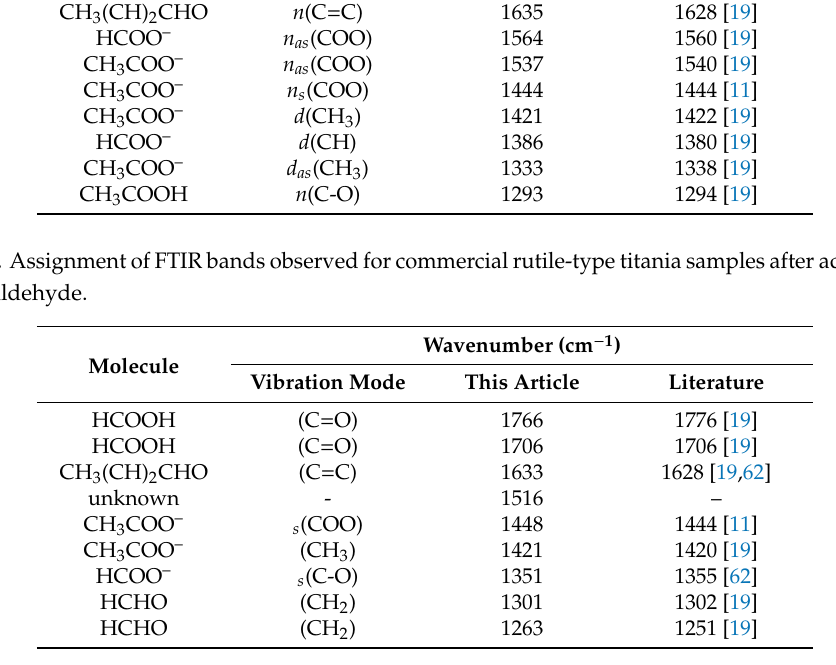
Table 7. Assignment of FTIR bands observed for commercial titania samples (P25, P90,